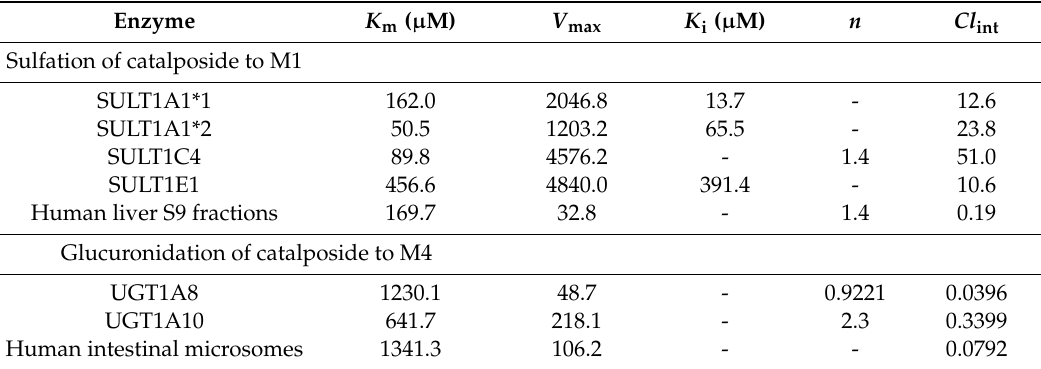
Table 2. Kinetic parameters for the formation of catalposide sulfate (M1) and catalposide glucuronide (M4) from catalposide in pooled human liver S9 fractions, intestinal microsomes, and human cDNA-expressed sulfotransferase (SULT) or UDP-glucuronosyltransferase (UGT) enzymes.